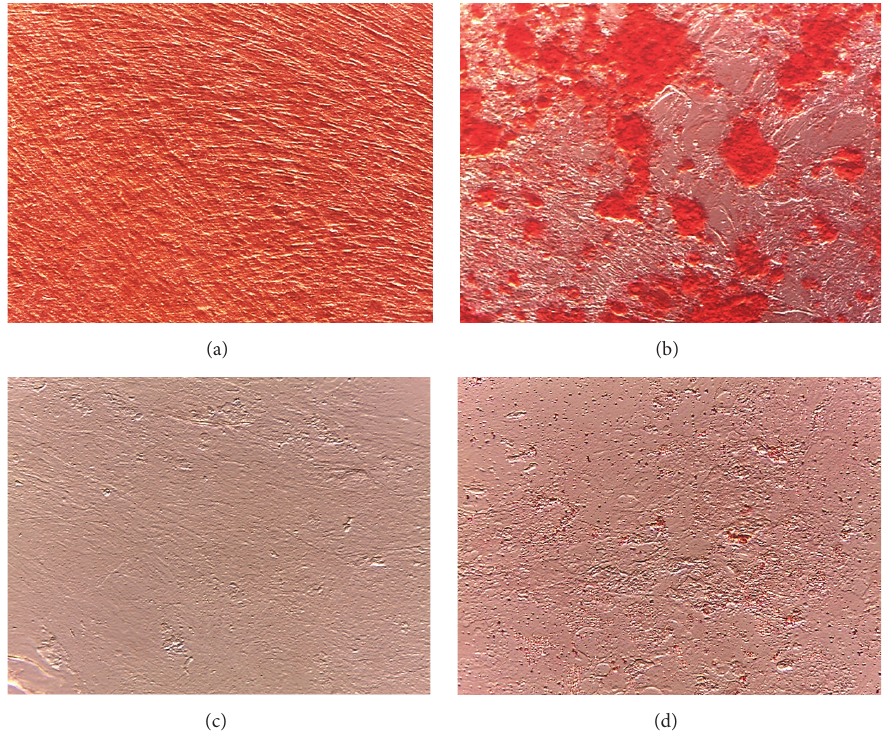
Figure 5: Pituitary adenoma cell cultures exhibited competence to differentiate into osteogenic and adipogenic lineages upon specific induction. Osteogenic differentiation was confirmed by Alizarin Red S staining of calcium inclusions (control (a), differentiated (b)). Magnification × 200. Adipogenic differentiation was confirmed by Oil Red O staining of lipid droplets (control (c), differentiated (d)). Magnification × 400